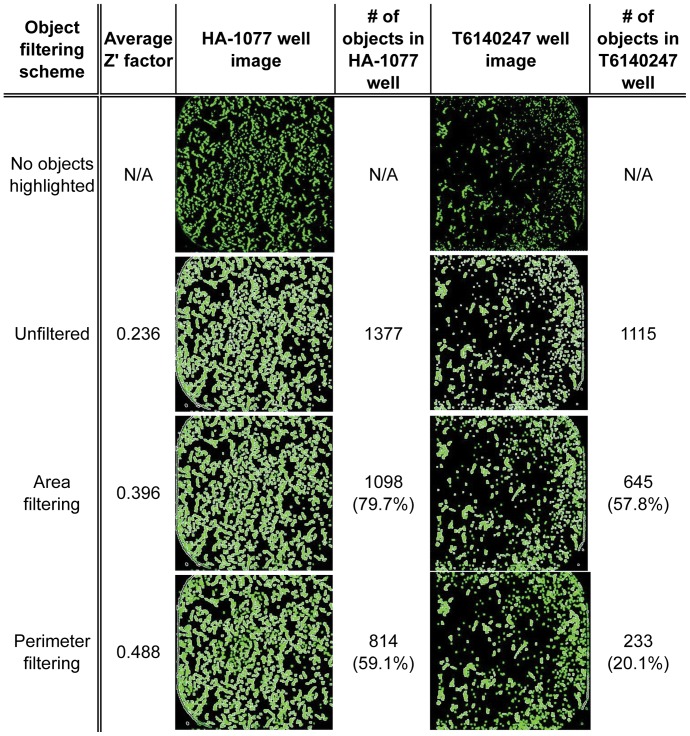
A perimeter-based object identification scheme results in the most robust detection of surviving hESCs.Three methods for quantifying Calcein staining of hESCs were compared: Unfiltered imposed no constraints on the object identification, while Area filtering requires fluorescent objects to have a perimeter ≥50 µm and area ≥125 µm2 to be counted and Perimeter filtering requires objects to have a perimeter ≥100 µm. Images compare the two compounds highlighted in Figure 4.6: HA-1077 (left) and T6140247 (right). For each category, objects identified are highlighted in white and quantified to the right of each image along with the percentage of the Unfiltered object count.